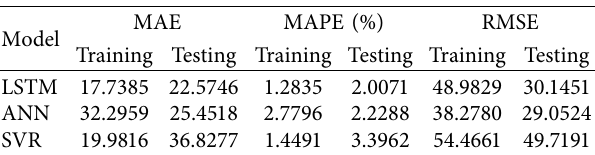
testing stage. Table 5 records the evaluation metric score of the three models on the experimental dataset, and the best score of each evaluation metric is shown in red.